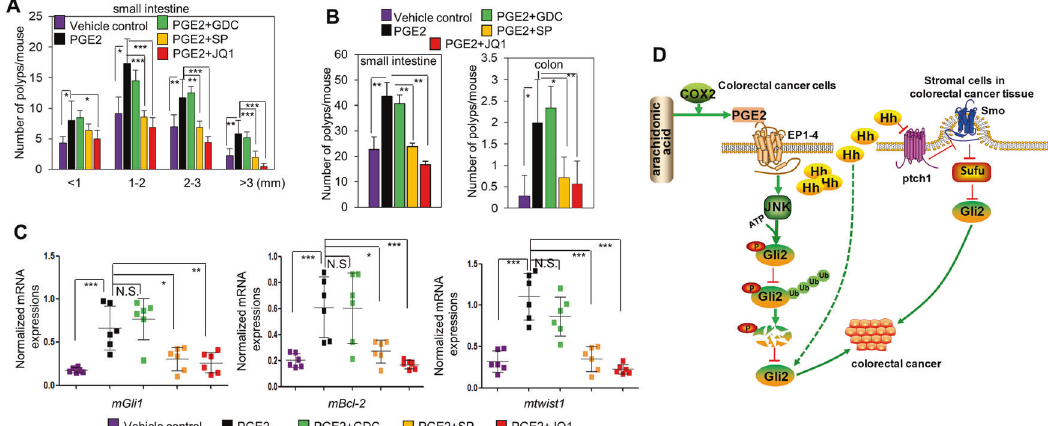
Fig. 5 PGE2-JNK signaling axis promotes intestinal tumor growth by non-canonically stimulating Hh activity in a Smo-independent manner in Apc Min/ + mice. A , B The intestinal polyp number and size in Apc Min/ + mice treated with PGE2,GDC,SP, and JQ1 as indicated for 2 months. Error bars represent SD ( n = 6). C The mRNA levels of Gli target genes in small intestine of mice treated with PGE2, GDC, SP, and JQ1 as indicated for 2 months. Error bars represent SD ( n = 6). D Schematic model depicting the activation of Hh signaling pathway in cancer cells and stromal cells in colorectal cancer.